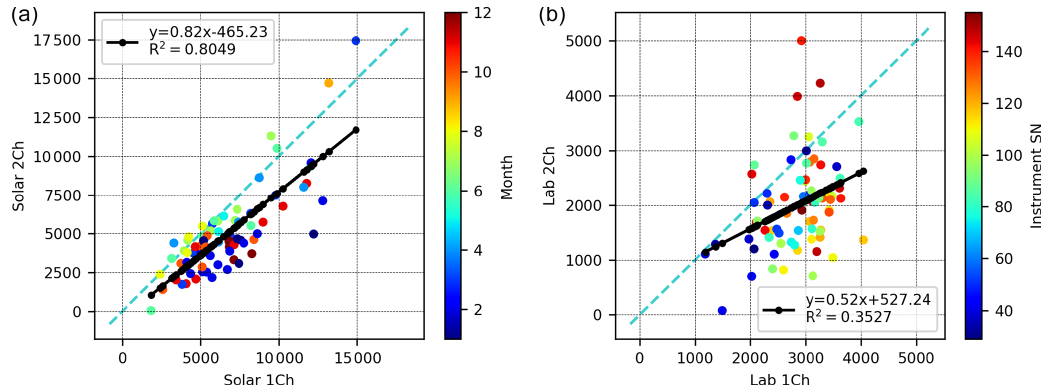
Figure 26. Correlations of the SNR obtained in channels 1 and 2, for the solar and OP measurements in (a) and (b) , respectively. In (a) the colour code represents the month of the year when the solar measurements were carried out, for demonstrating the absence of an obvious seasonal signal in the SNR characteristics. In (b) , the colour code represents the instrument’s serial number because these measurements are carried out under controlled laboratory conditions by using a lamp as a light source. There might be a slight tendency towards higher SNR in recently built spectrometers.